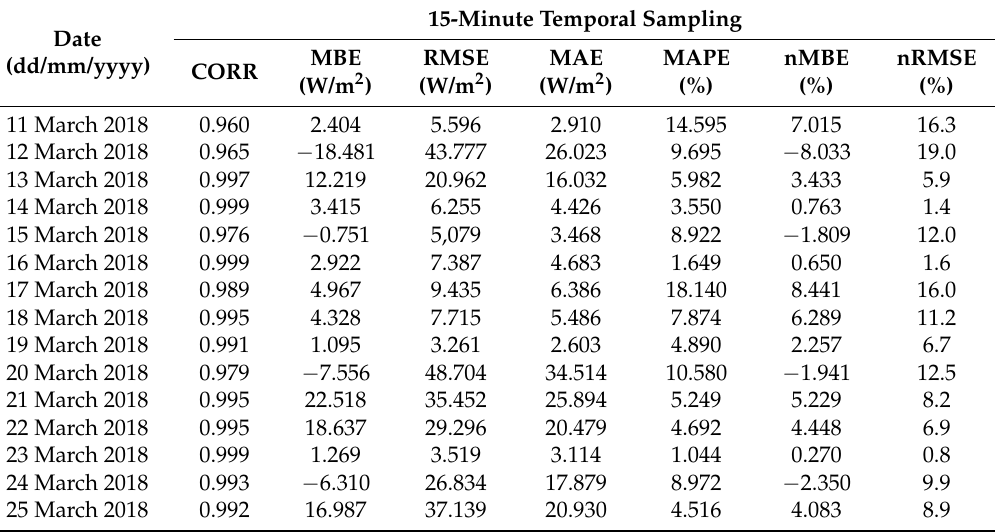
Table 4. Results of the statistical assessment for AMESIS product based on 15-minute temporal sampling against ground measurements at the Ispra